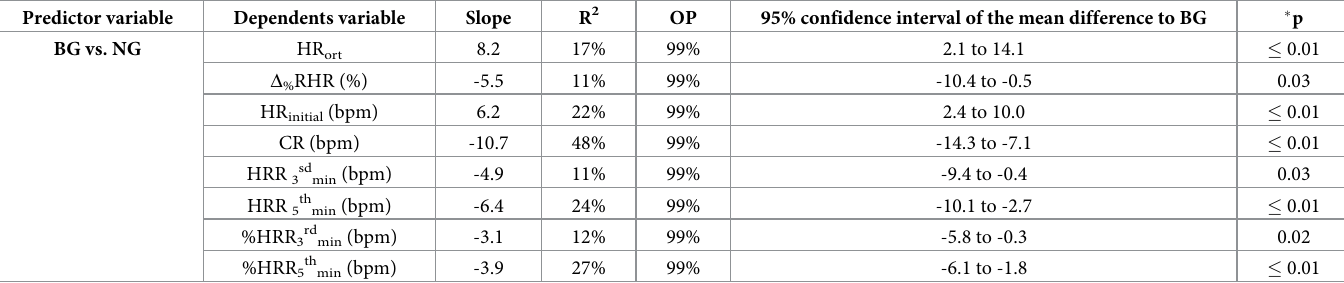
Table 4. Simple linear regression analysis derived from differences between means of the groups on a chronotropic response before, during, and after a submaximal exercise test. Predictor variable